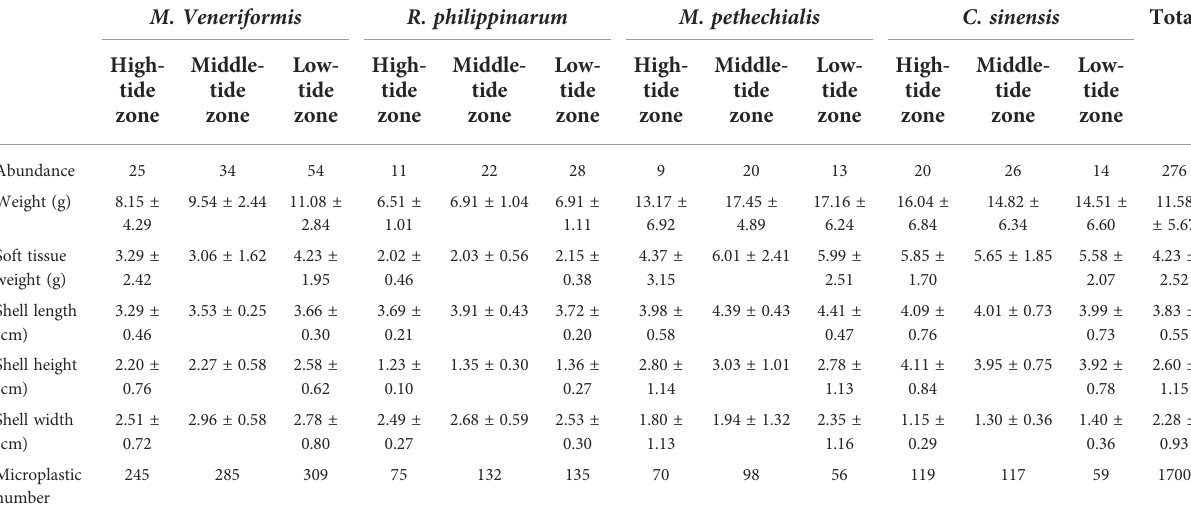
TABLE 1 A summary of the characteristics of the clam samples. Biological parameters are expressed as mean ±